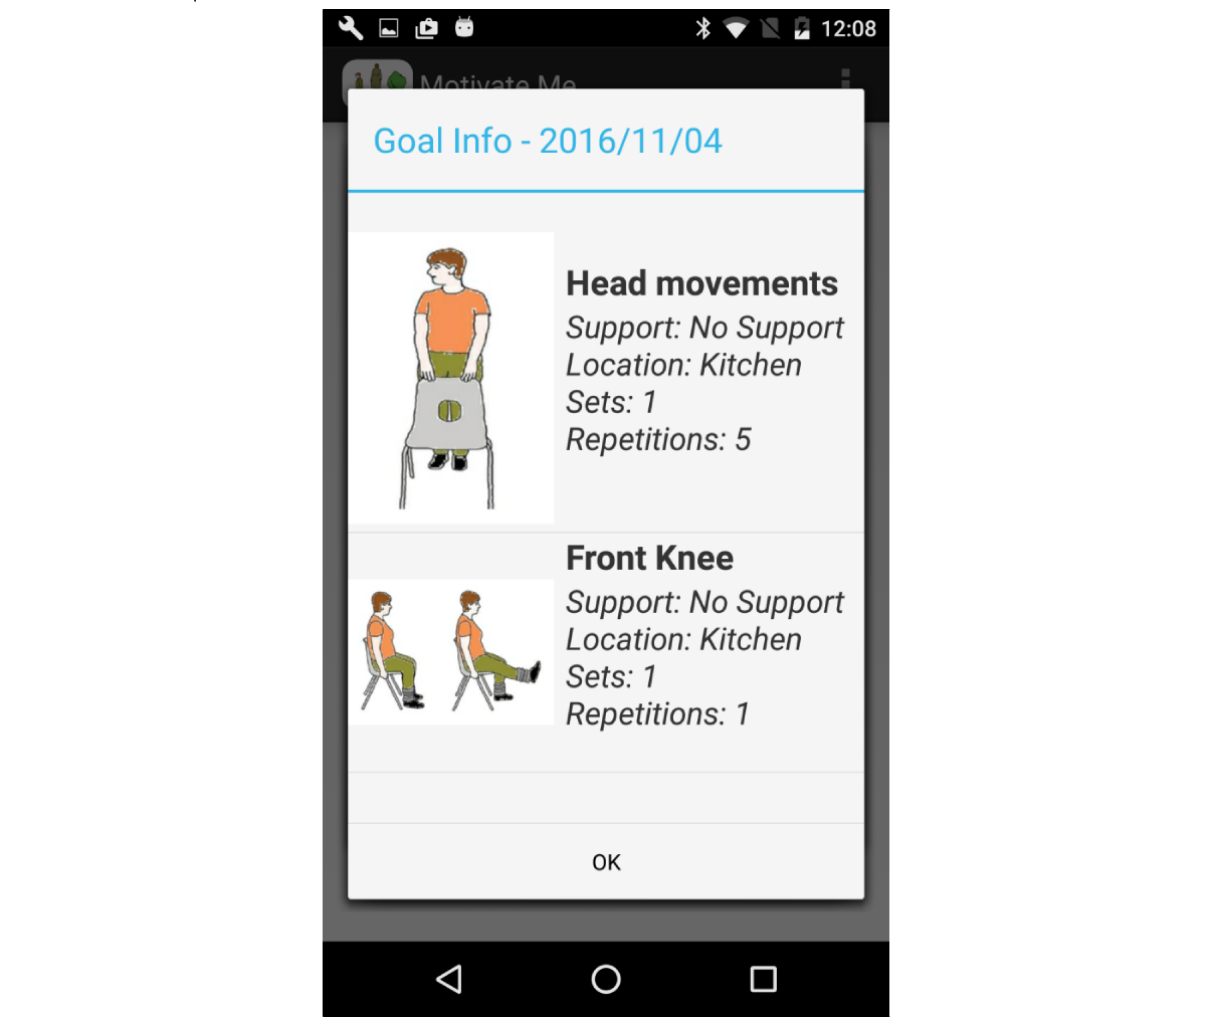
Figure 1. Interface: example of